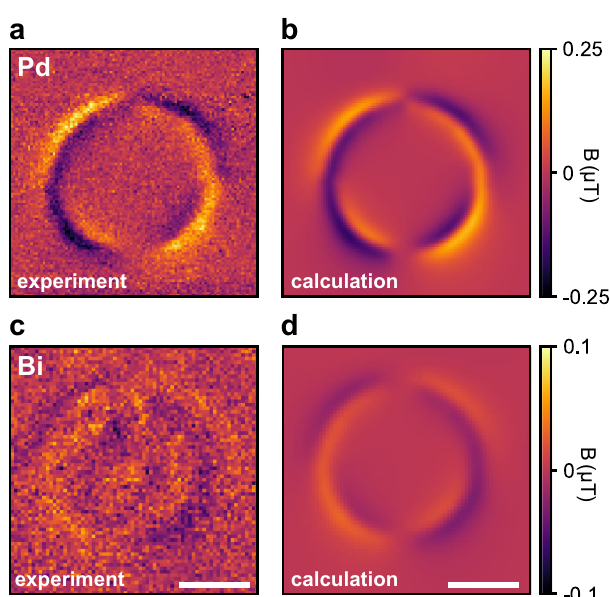
Fig. 5 Nanoscale susceptometry. a Measured B 1 image of a 2- μ m-diameter paramagnetic Pd disc in a 35 mT bias fi eld. b Calculated B 1 image (best fi t) of the Pd disc. c , d Corresponding measurement, and calculation for diamagnetic Bi in a bias fi eld of 33 mT. Offsets of 51 nT and 38 nT due to the gradient of the external bias magnet are subtracted from a and c , respectively. See Methods for calculation and fi t details. Scale bars, 1 μ